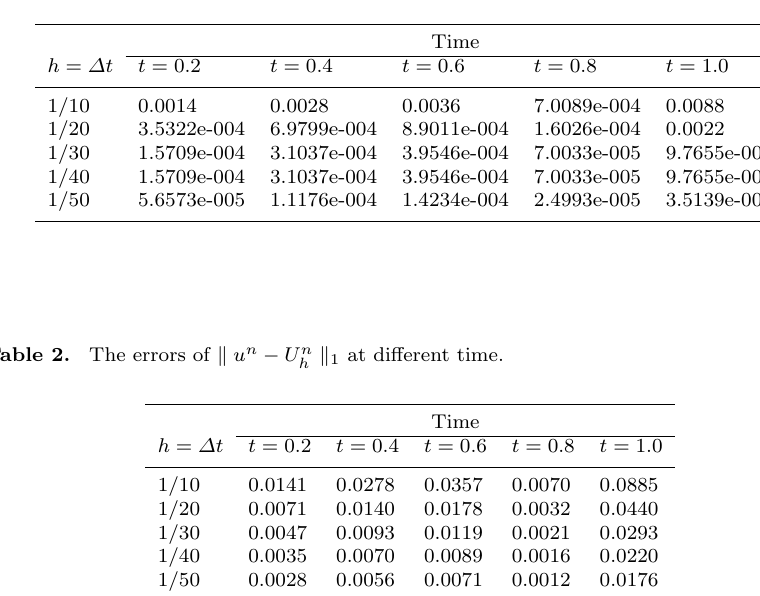
(cid:107) at different time. h Time